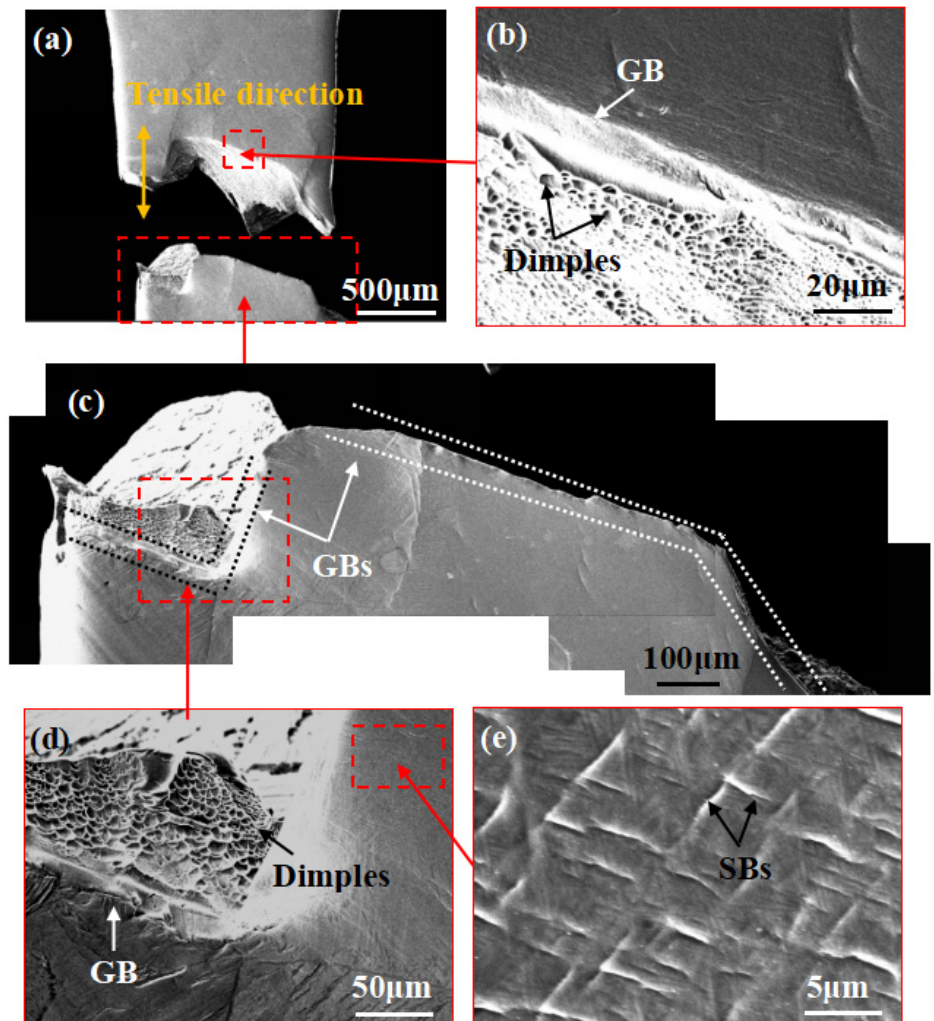
Figure 11. ( a ) In situ SEM images of the lamellar microstructure at position C’; ( b , d ) magnified images showing many small, shallow dimples on the fracture surface; ( c ) magnified image showing the sample with a shape fracture surface generally breaking along the GB; ( e ) some short crossed SBs are shown in the β matrix adjacent to the fracture surface.